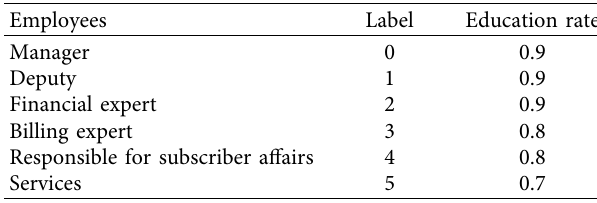
Table 2: Te staf education